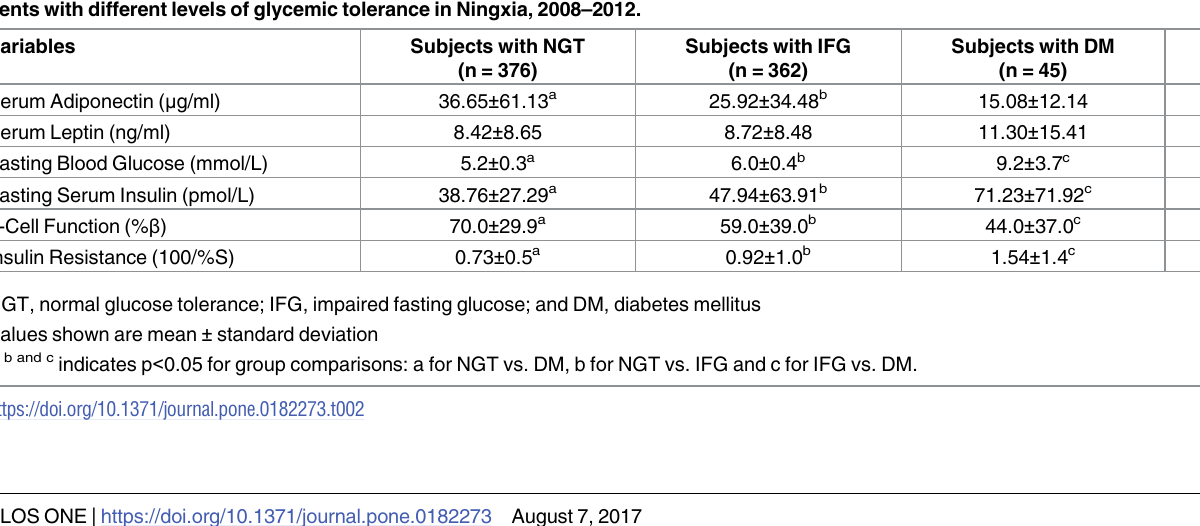
Table 2. Differencesin serum concentrations of adipocytokines, blood glucose, insulin, and HOMA parametersamong 783 rural Chinese resi- dents with different levels of glycemic tolerance in Ningxia, 2008–2012.